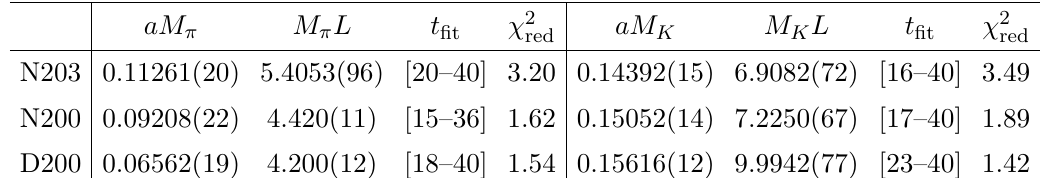
Table 3. Single-hadron energies at rest, determined from single-exponential fits. The range of time separations included in the fit is given by t fit . The high χ 2